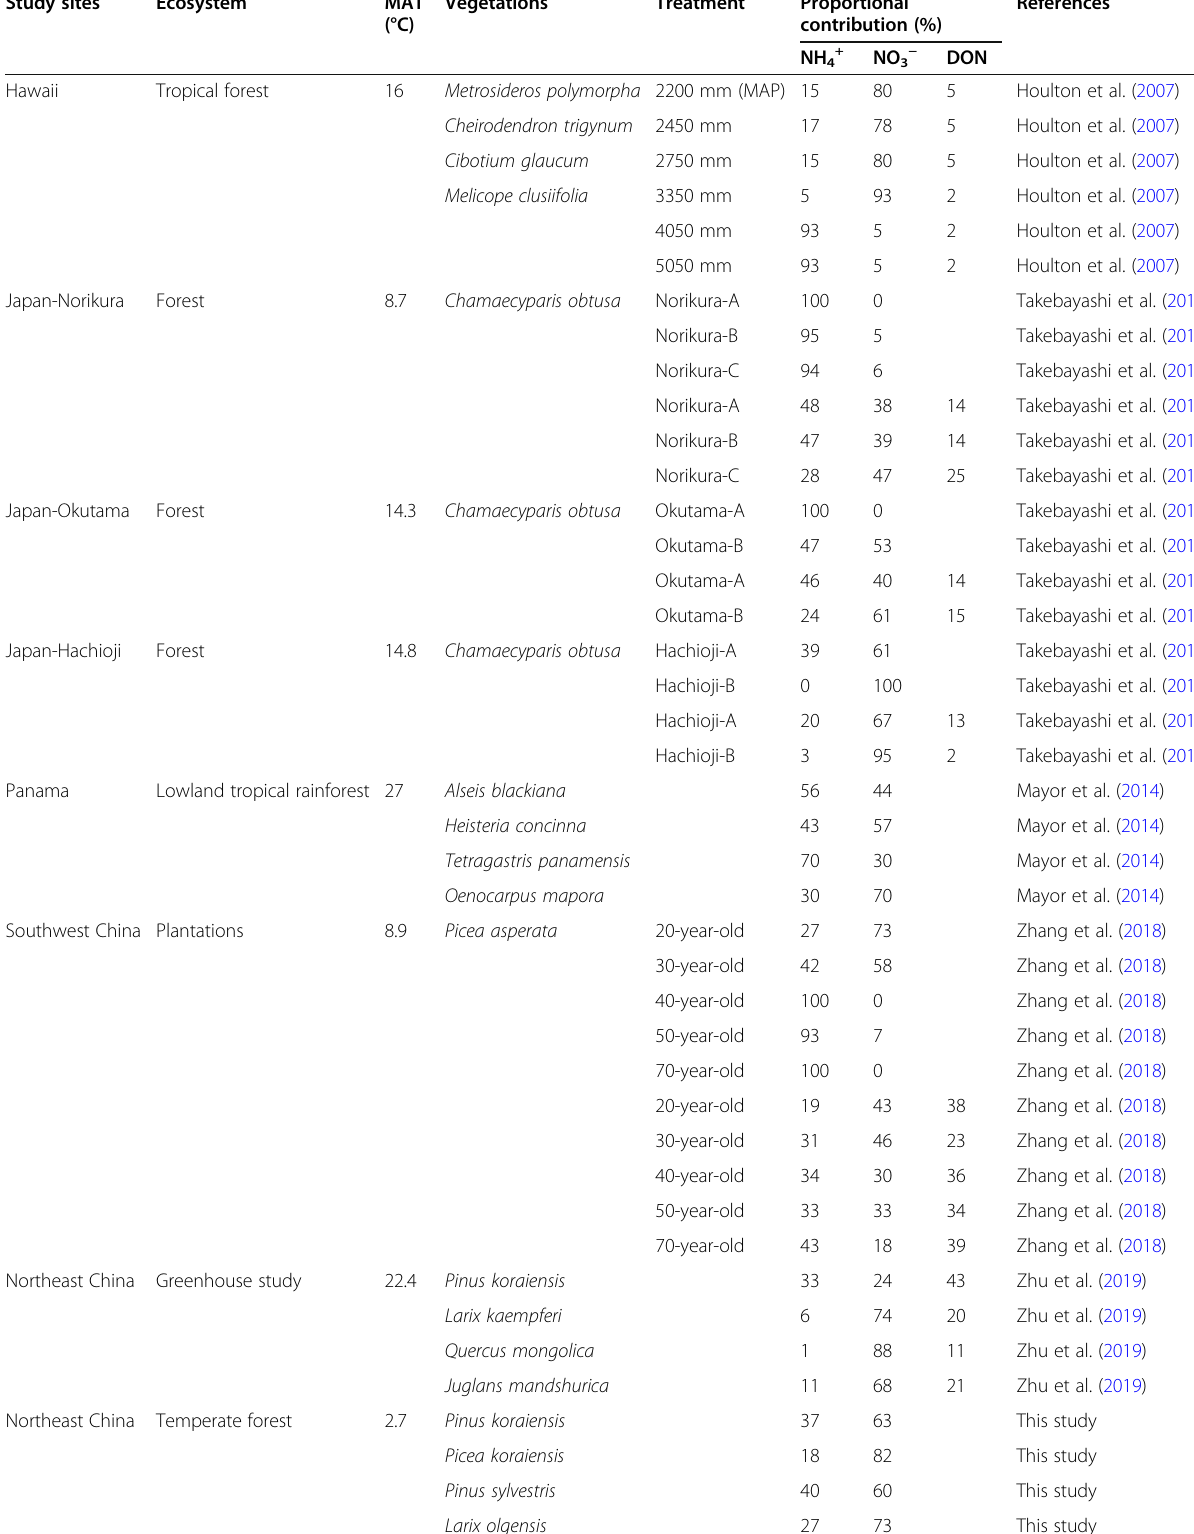
Table 1 The proportional contribution of different N forms to plant N uptake in forest trees by using the 15 N natural abundance